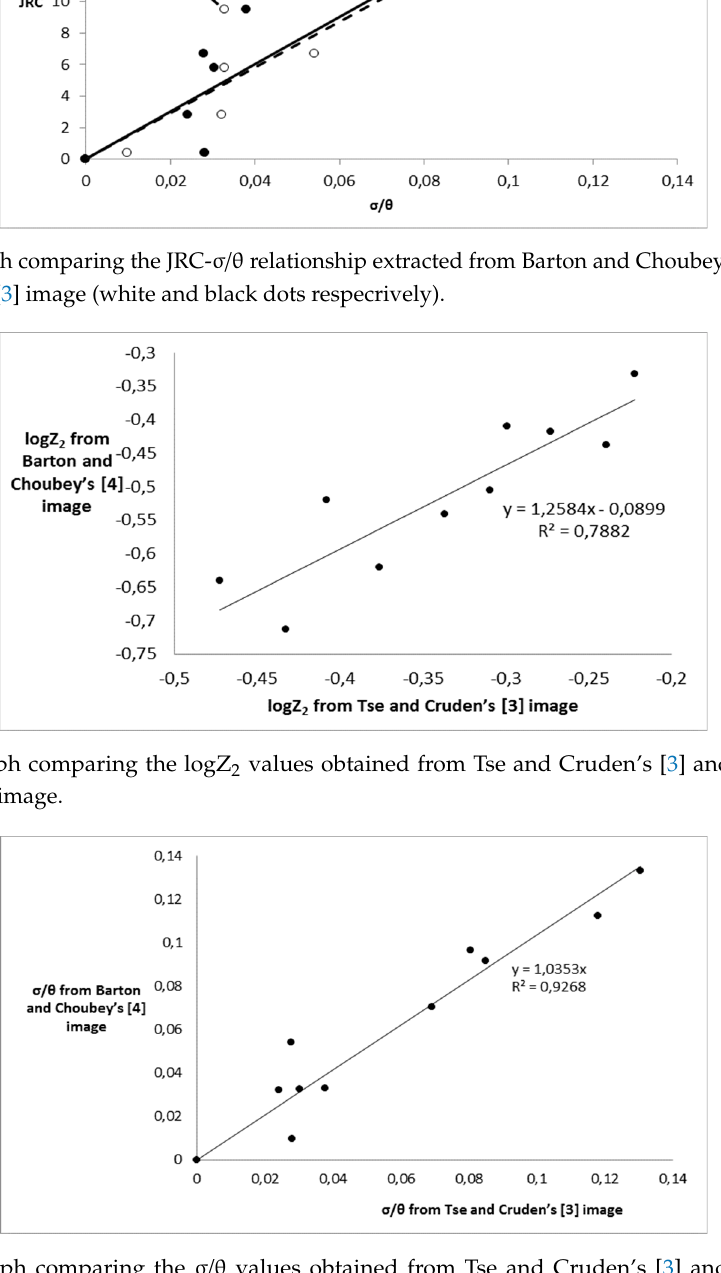
Figure 7. Graph comparing the σ / θ values obtained from Tse and Cruden’s [3] and Barton and Choubey’s [4] image.